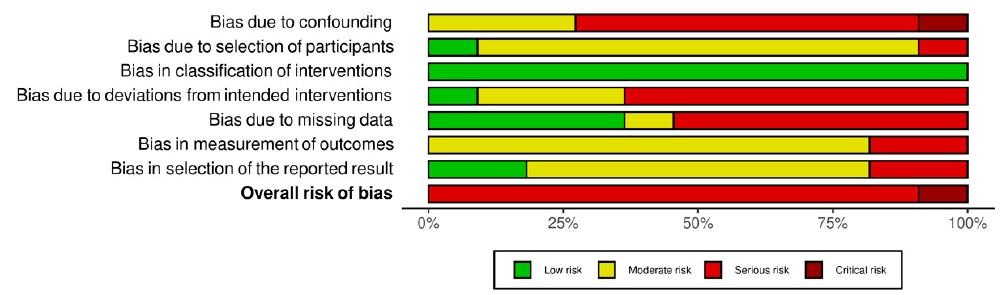
Figure 5. Percentages of risk bias in non-randomized control trials (green: low bias risk; yellow: moderate bias risk; red: serious bias risk; brown: critical bias risk; blue: no information).